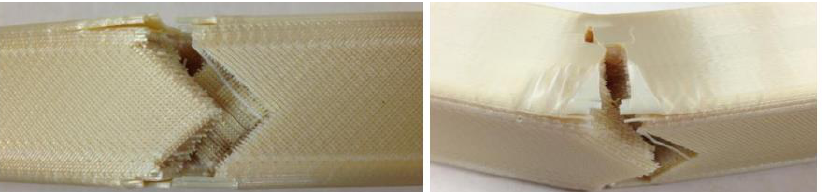
Figure 8. Gapped control sample that stayed together after the 3-point beam test, viewed from beneath ( left , rastered bottom/top) and sideways ( right , contoured sides) [51]. Credit: NASA. Table 2. Break characteristics, flexural modulus, and dimensions/mass change in samples according to applicant types and airgap configuration [51 – 55].